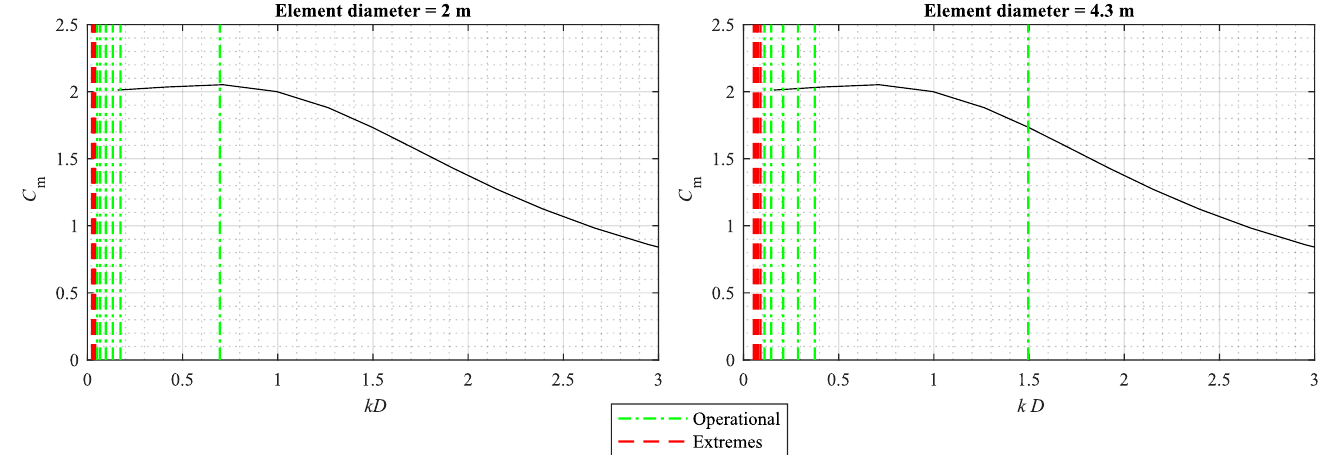
Figure 11. Inertia coefficients, as defined in [24], for the smallest ( left ) and largest ( right ) element in the TetraSpar. Table 6. Surge motion response for the three models with and without improved C m . The relative difference is with the hybrid approach. Morison Original C m Updated C m BEM Hybrid Parameter Value Rel. diff. Value Rel. diff. Value Rel. diff.